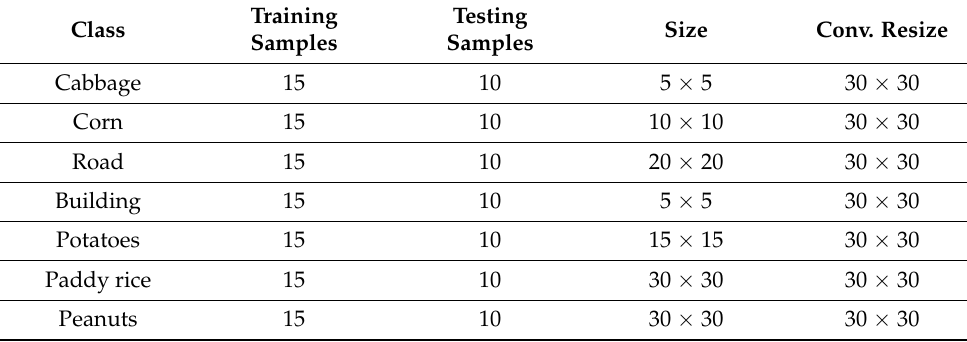
Table 4. The cell-size of the CNN